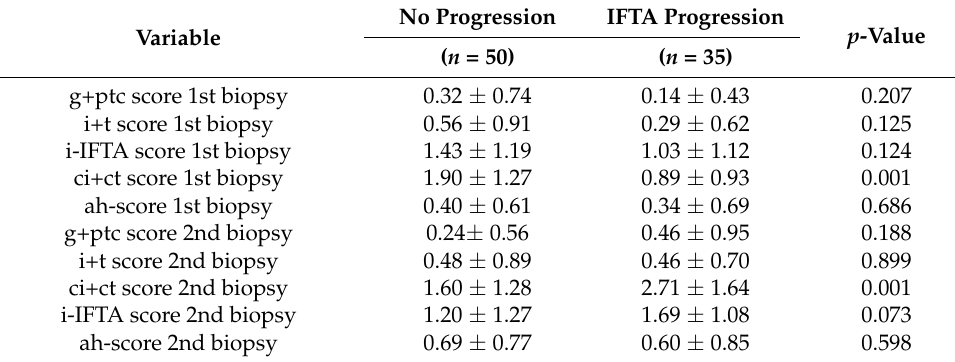
Table 7. Banff scores in the first and second surveillance biopsies in patients with and without IF/TA progression between